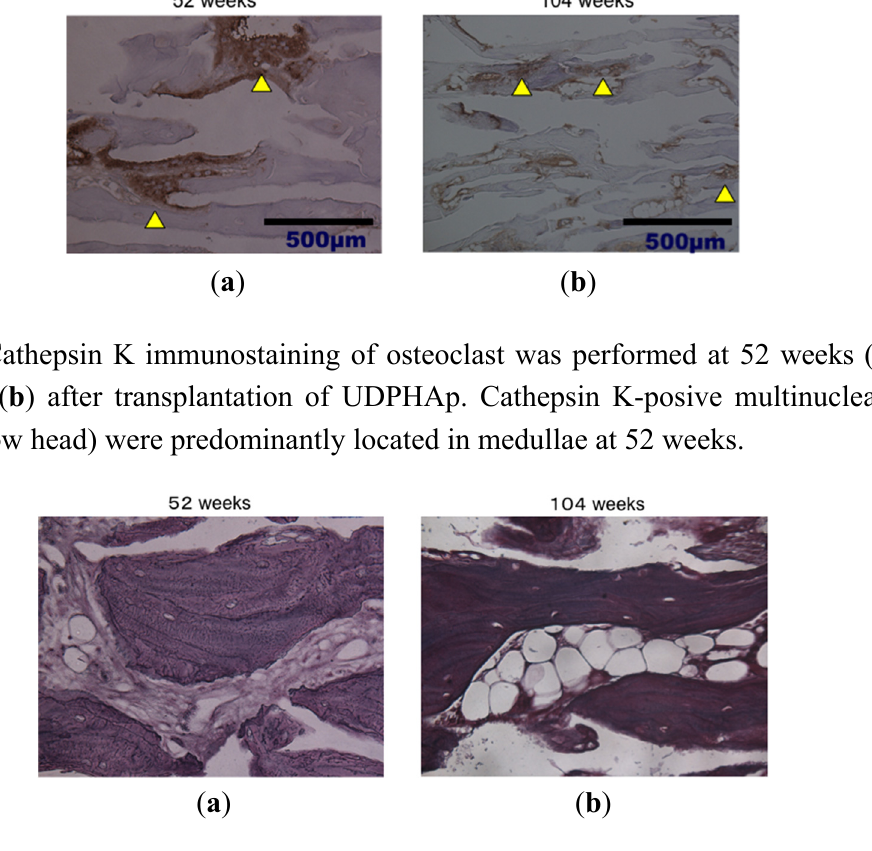
Figure 7. Bodian staining at 52 weeks ( a ) and 104 weeks ( b ) after transplantation of UDPHAp. The lamellar structure of the newly-formed bone was more developed at 104 weeks after UDPHAp